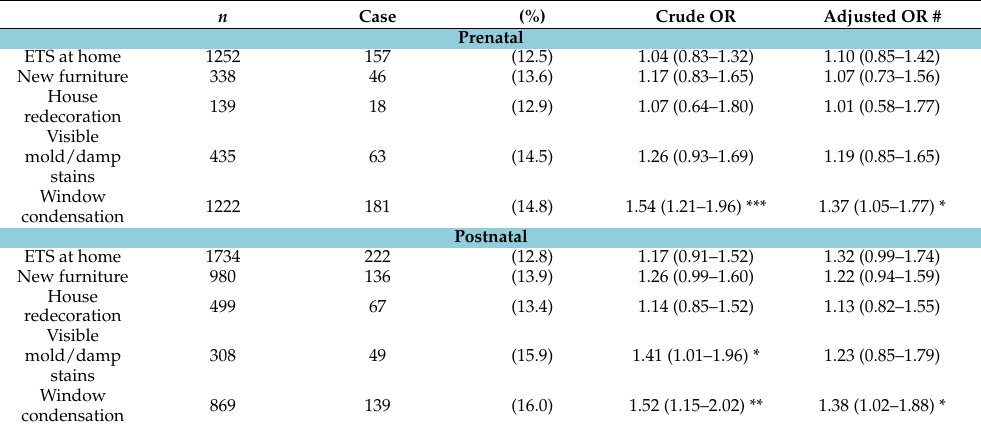
Table 4. Odds ratio (95% CI) of childhood annual SAR to pollen for exposure to indoor environmental factors during prenatal and postnatal periods ( n =